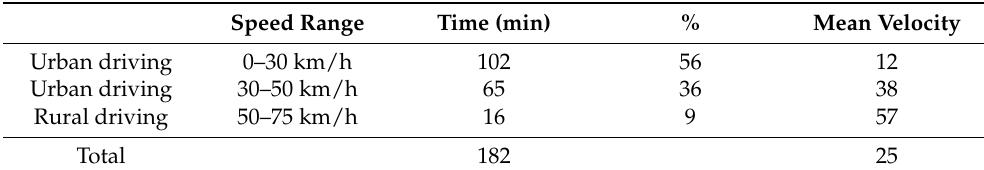
Figure 3. Speed profile of the driving circuit. Table 4. Shares of driving speed ranges.